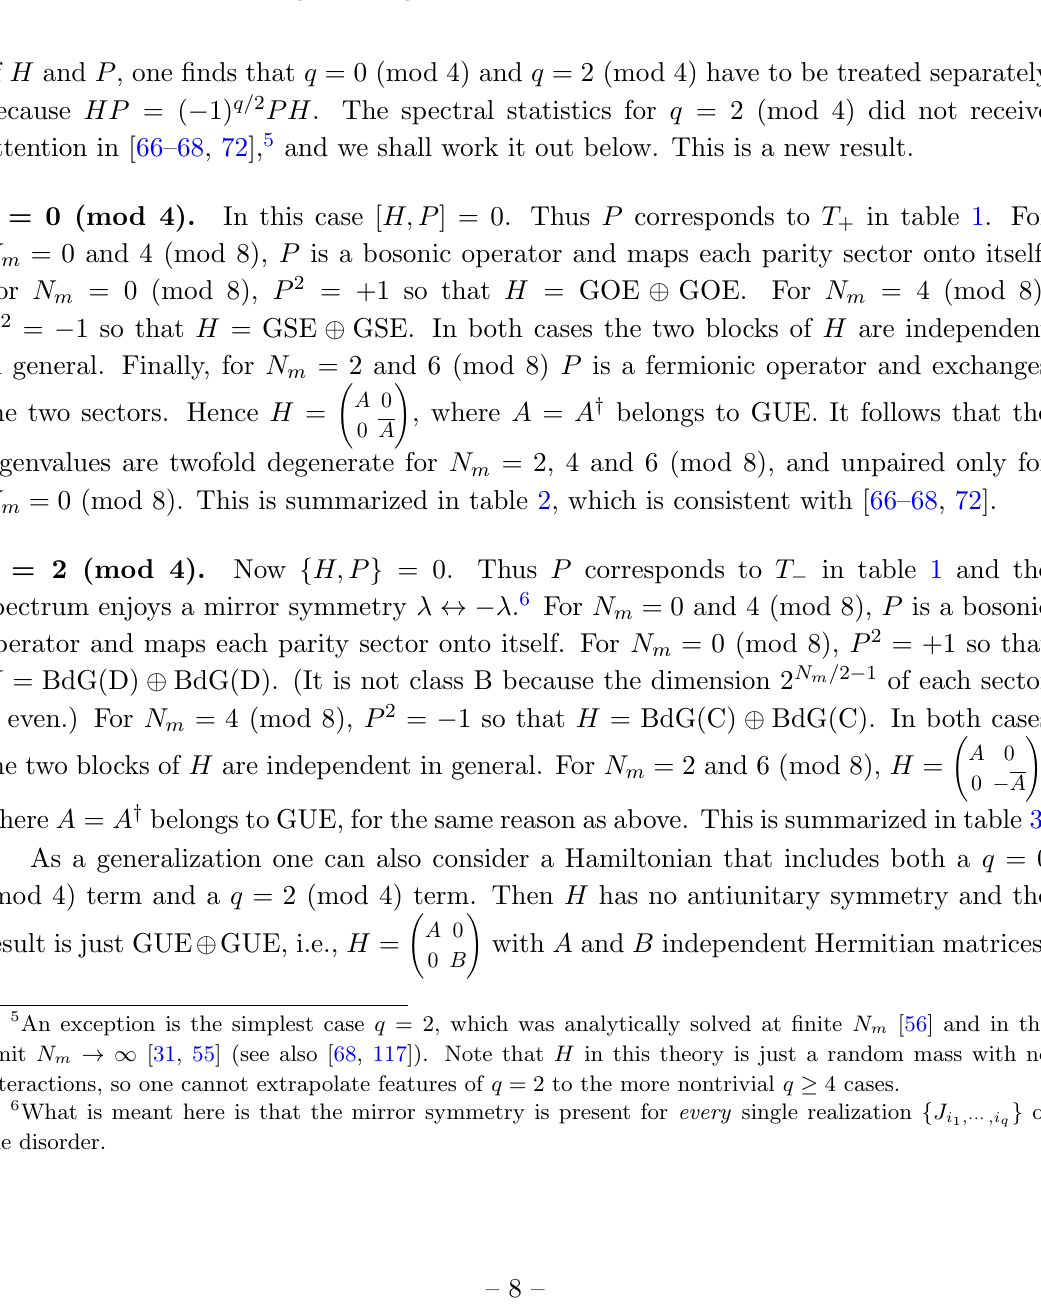
Table 2 . Symmetry classi(cid:12)cation of H in the Majorana SYK model (no SUSY) for q = 0 (mod 4). This table is consistent with [66{68,